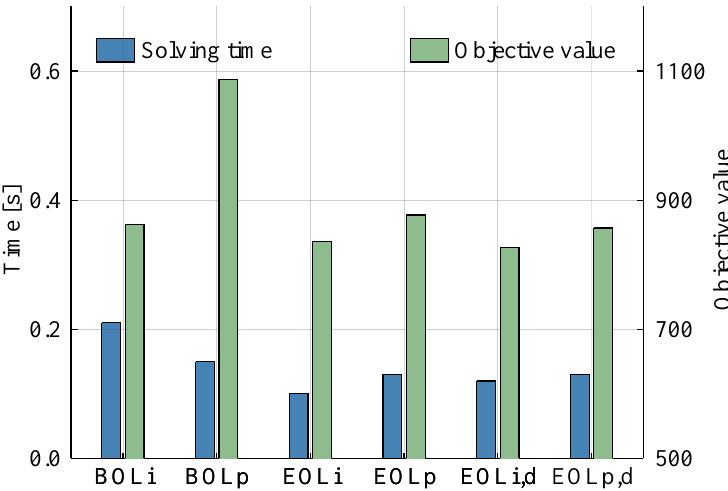
Figure 17. Scheduling solving time and resulting objective value for each power input